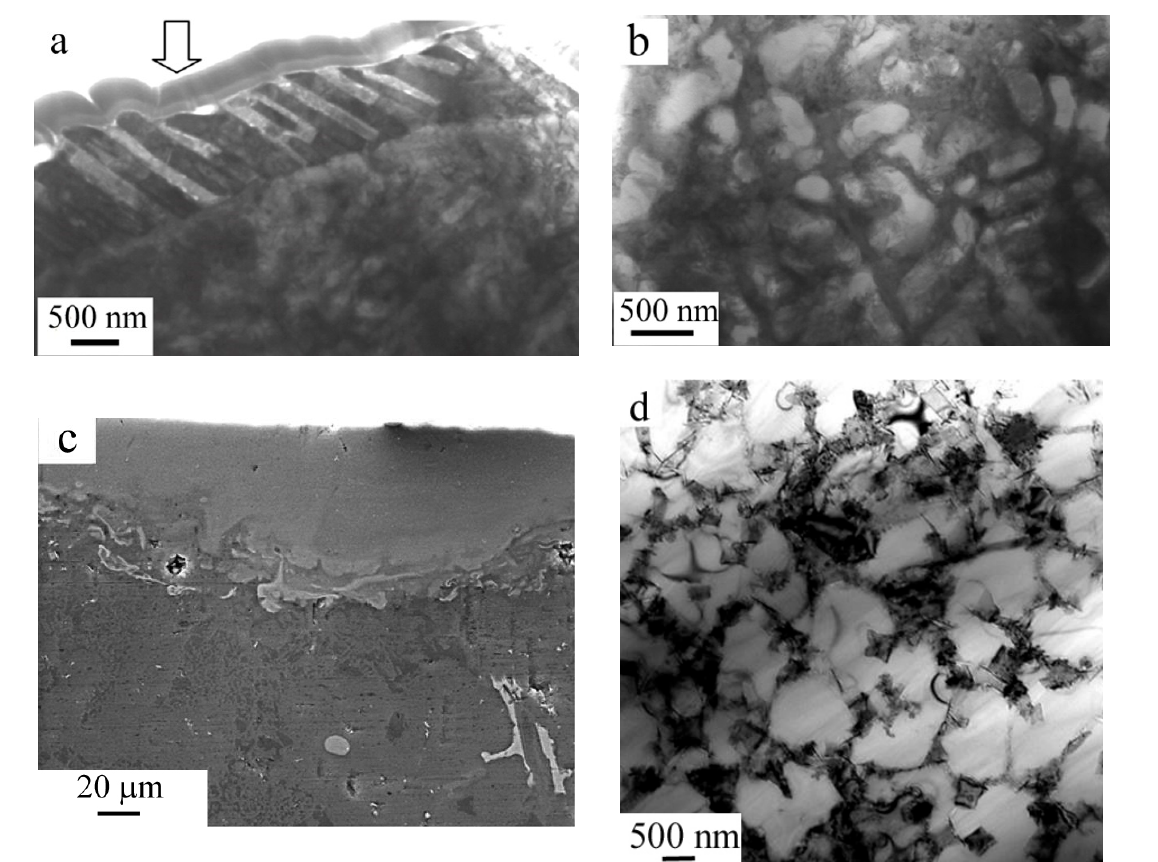
Figure 1. The structure of yttrium-doped titanium ( a , b ), and silumin ( c , d ) surfaces irradiated by an electron beam.